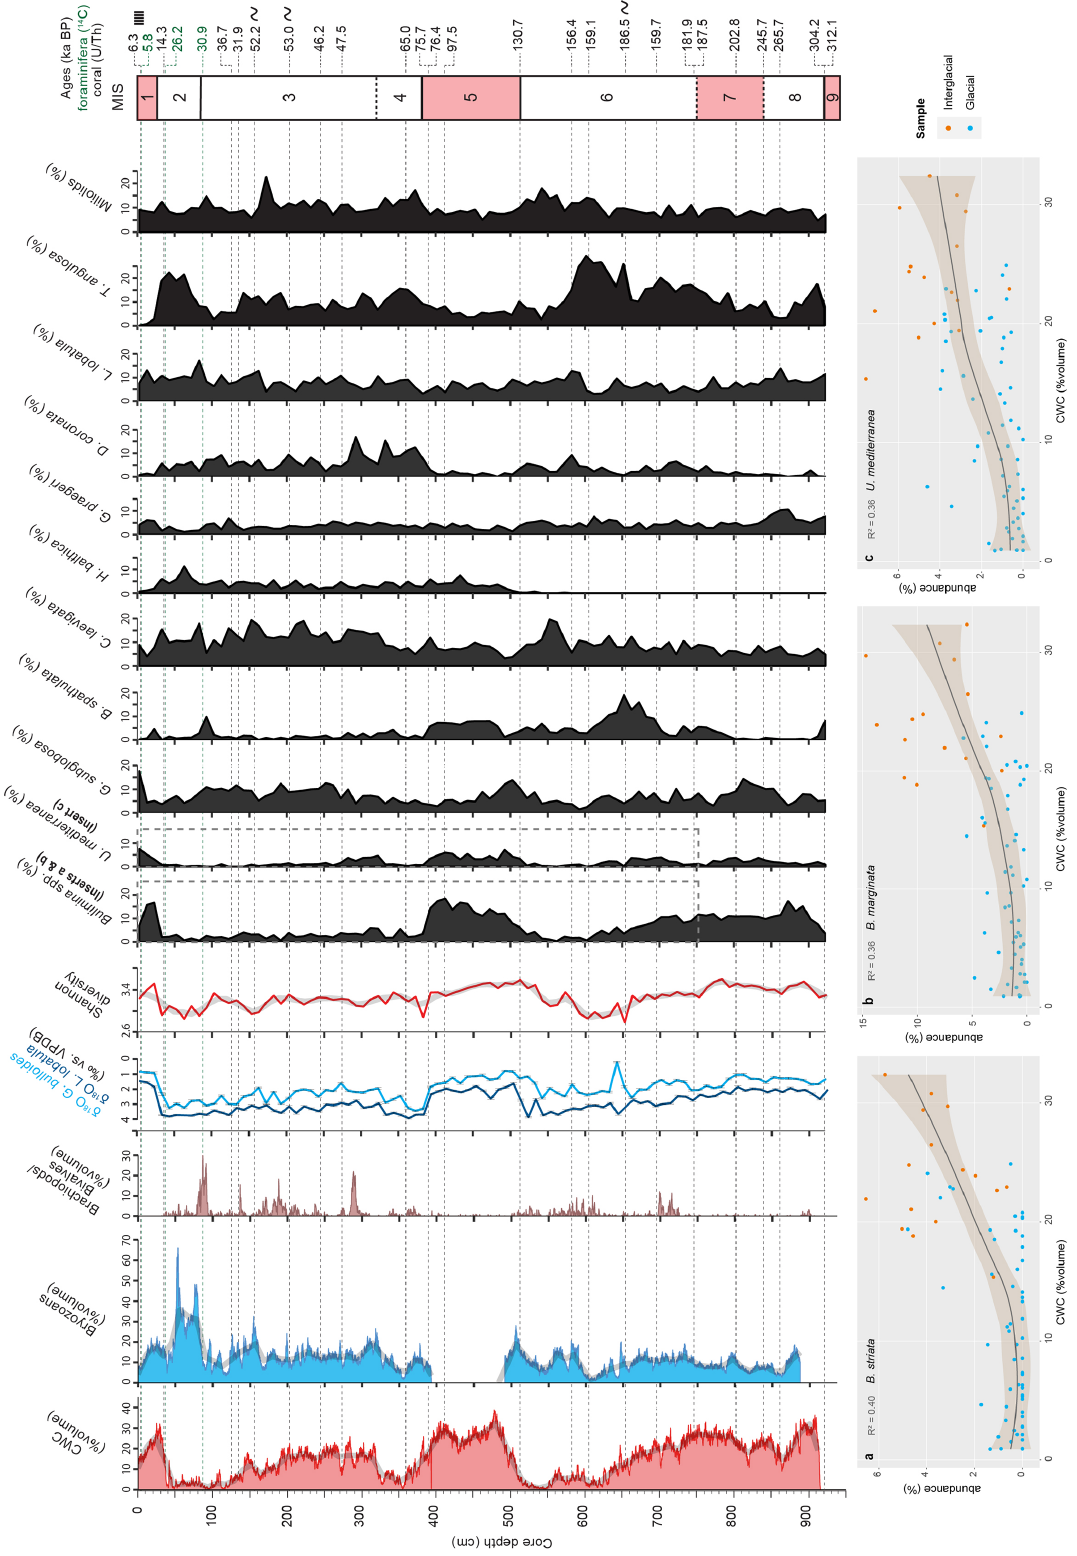
Figure 8. Distribution of main benthic foraminifera species (relative abundances) and benthic foraminiferal Shannon diversity. The plank- tonic ( G. bulloides ) and benthic ( L. lobatula ) δ 18 O records (‰, VPDB) are provided as supporting information. Panels (a) , (b) , and (c) : relative abundance of B. striata , B. aculeata , and U. mediterranea vs. CWC content (vol%) over the last two interglacial–glacial cycles (dashed grey rectangles). Shaded brown outlines represent the locally weighted regression (Cleveland and Devlin,